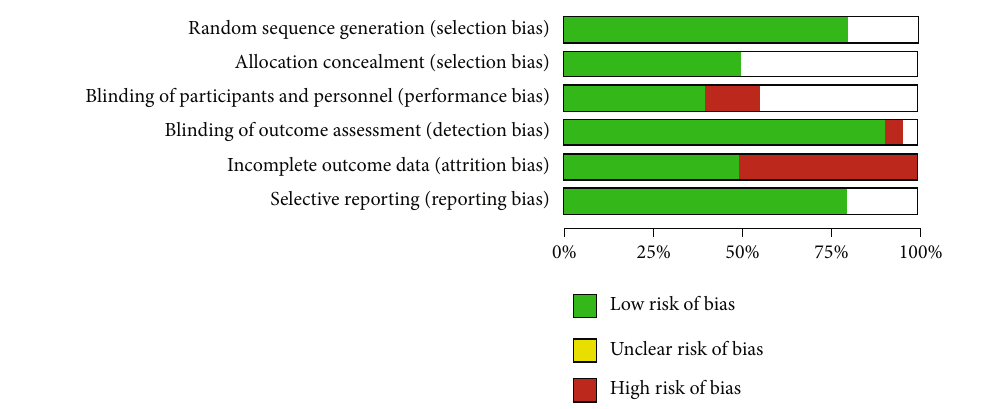
Figure 4: Risk of bias graph for included studies in dose-response